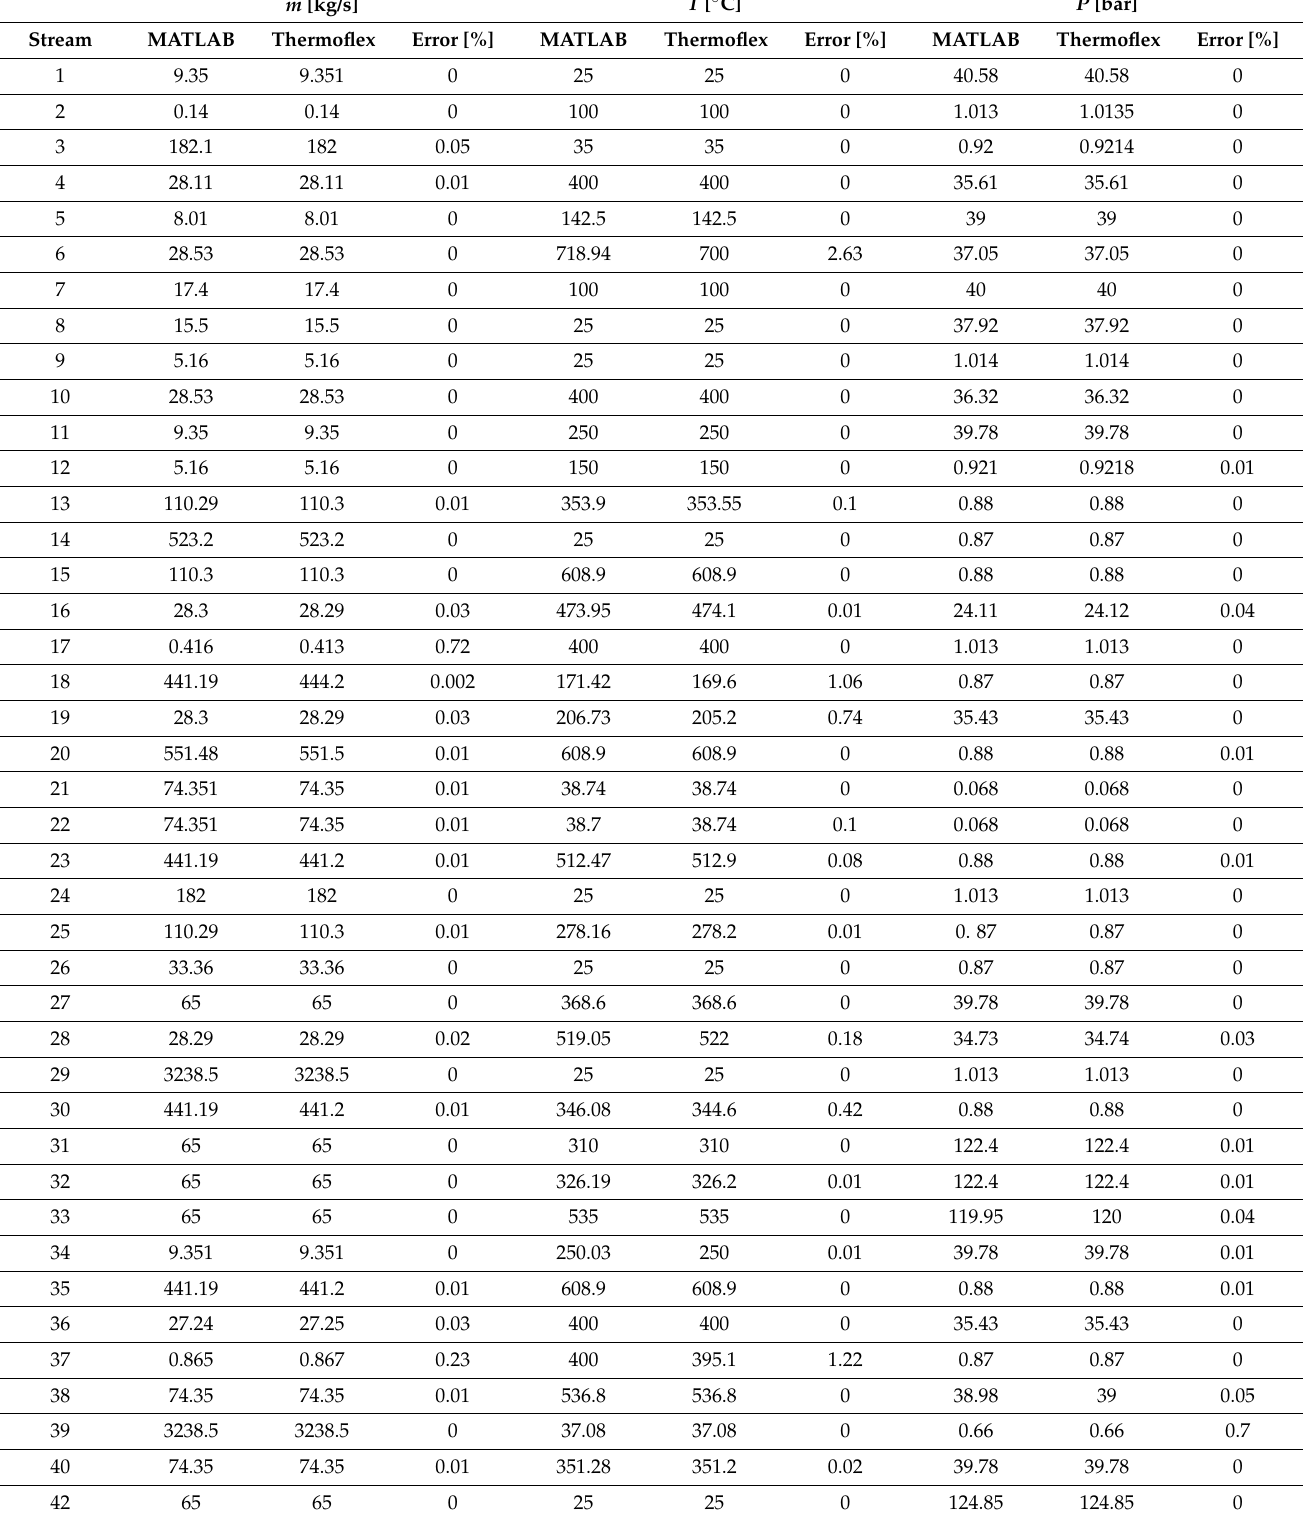
Table 2. Stream data obtained from simulations in MATLAB and Thermoflex